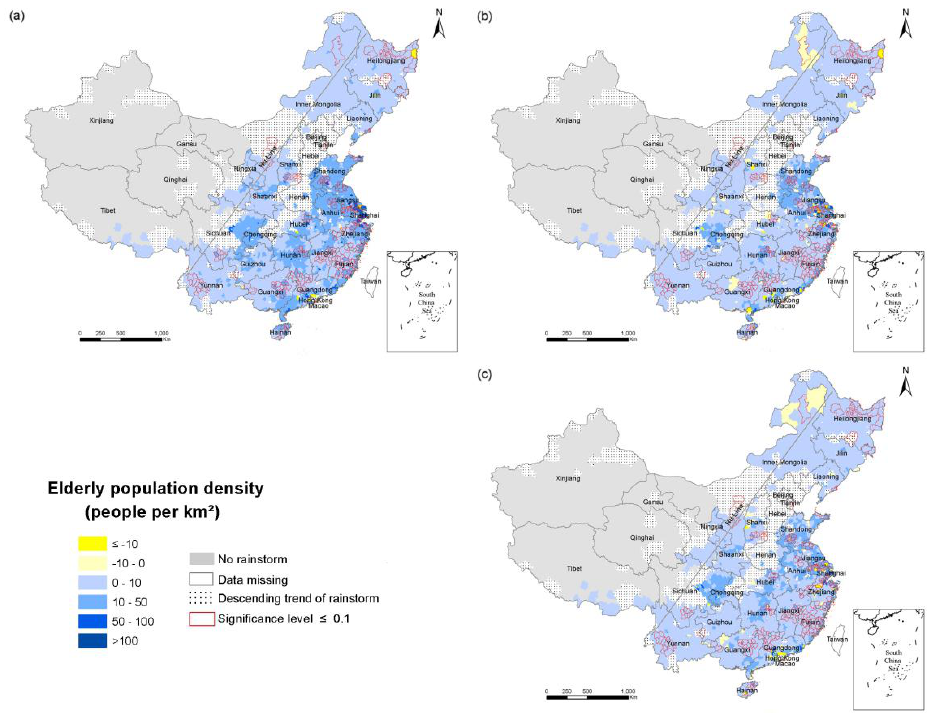
Figure 7. The change in the density of the elderly population in the RSHA ( a ) from 1900 to 2010; ( b ) from 1990 to 2000; ( c ) from 2000 to 2010.